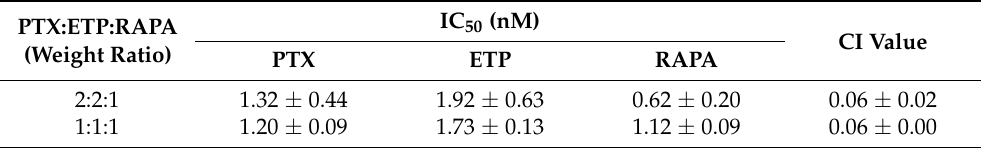
Table 1. Half-maximal inhibitory concentration (IC 50 ) and combination index (CI) values at two ratios of paclitaxel (PTX), etoposide (ETP), and rapamycin (RAPA) (n =